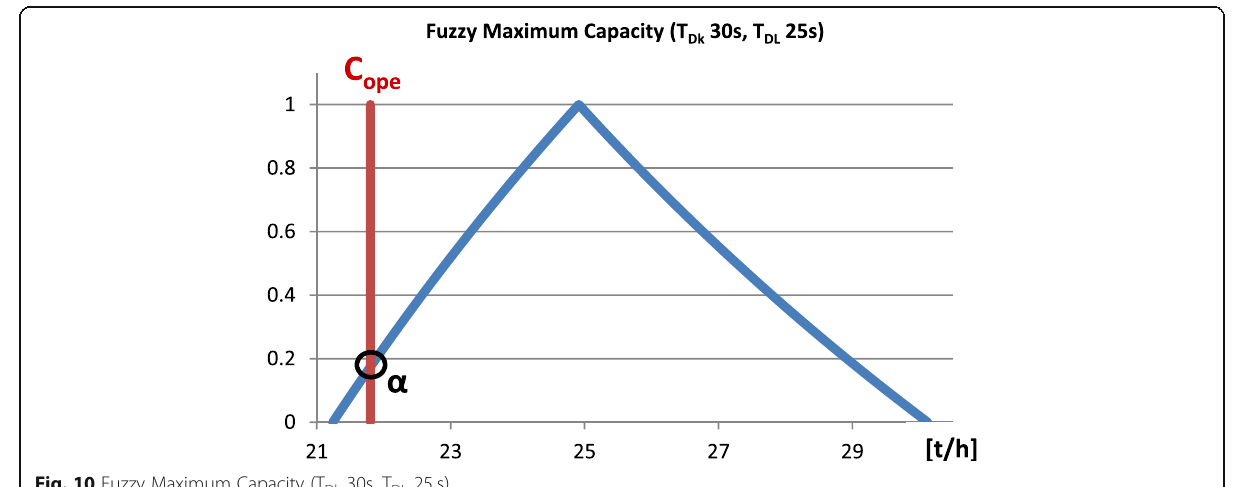
Fig. 10 Fuzzy Maximum Capacity (T Dk 30s, T DL 25 s)